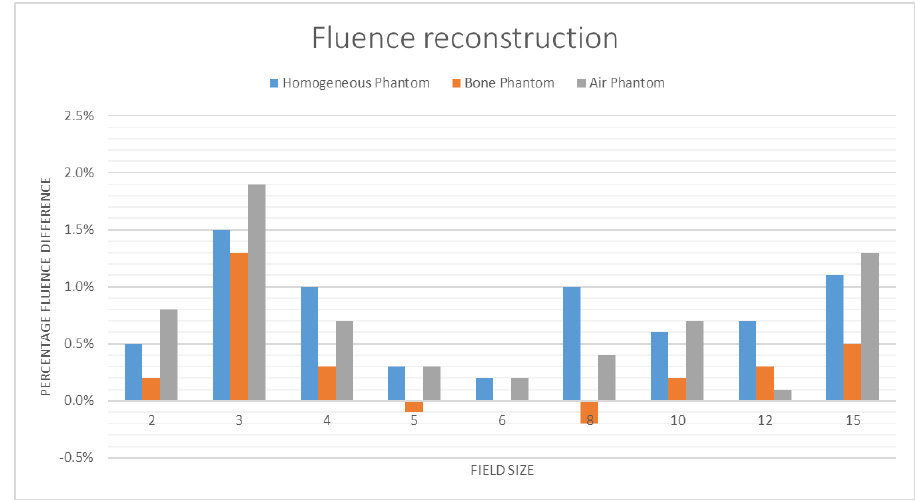
Figure 3. In this figure, the primary fluence reconstructed by the deconvolution kernel of DC in the slab phantom with homogeneous insert is shown with bone-like insert and with air insert.